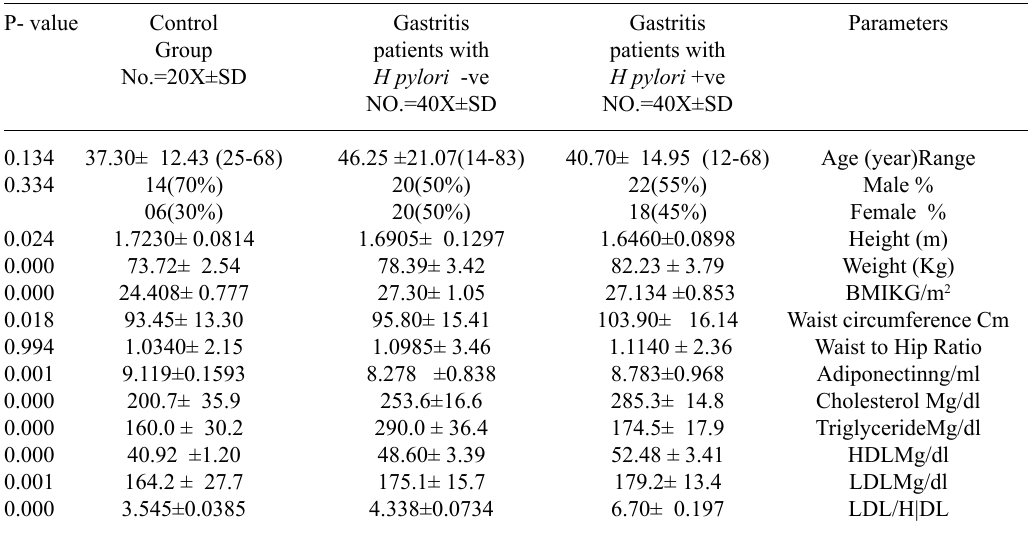
table 1. Demographic differences of various parameters among patients with gastritis with and without H pylori infection and control group